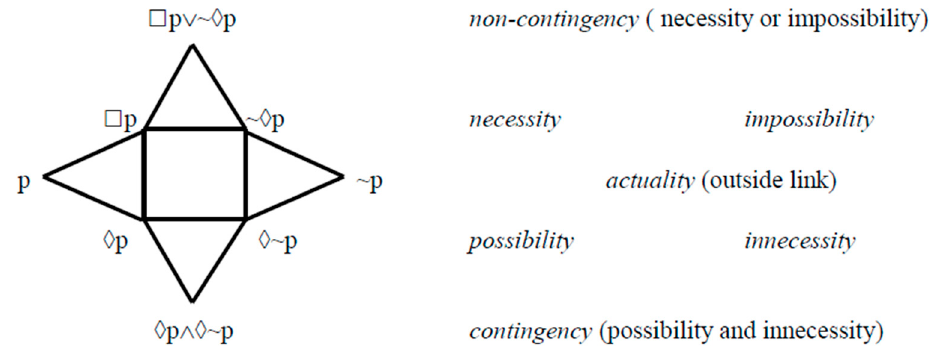
Figure 3. System Σ 2.